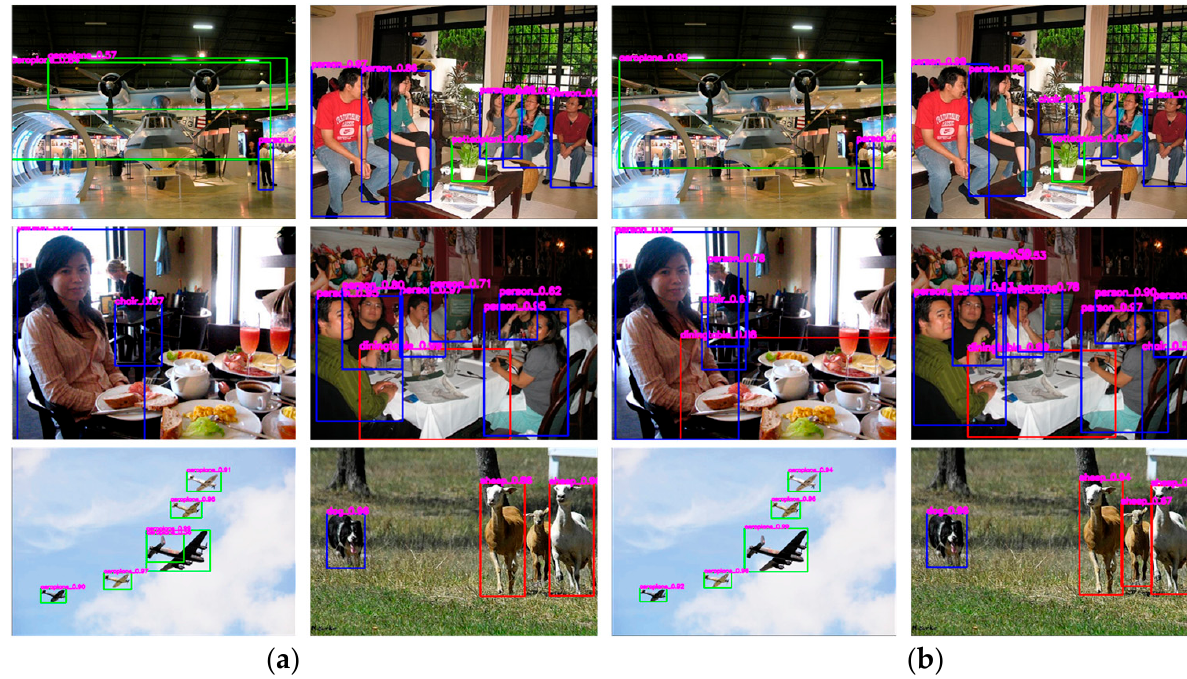
Figure 9. Test of images after improvements: ( a ) on the left is use of the SSD; ( b ) on the right is use of the ADSSD.